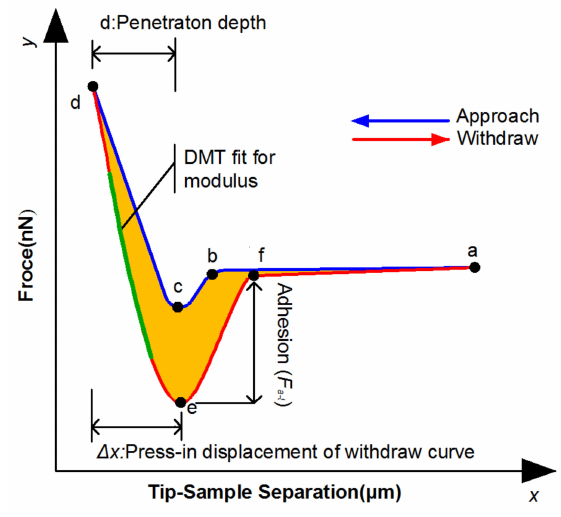
Figure 3. Force curve schematic